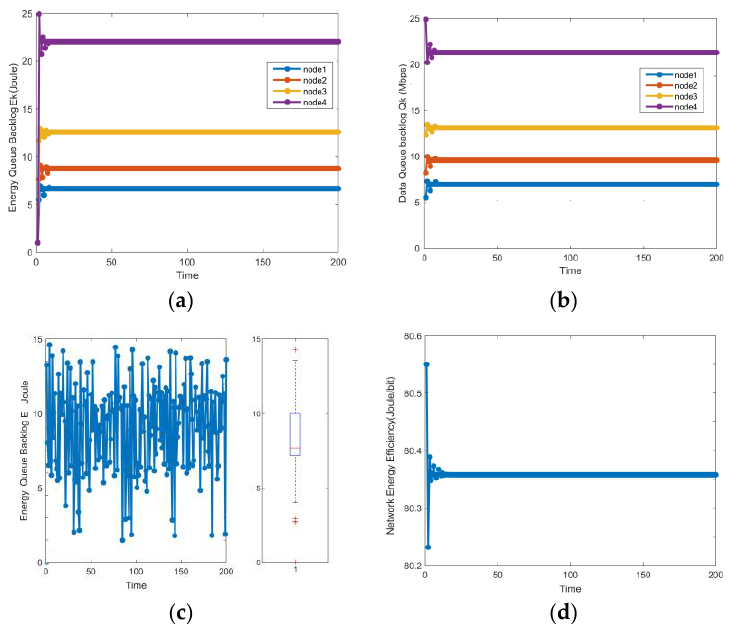
Figure 2. Analysis of queue stability ( a ) energy queue of node k ( b ) data queue of node k ( c ) energy queue of HAP ( d ) network average energy efficiency queue.